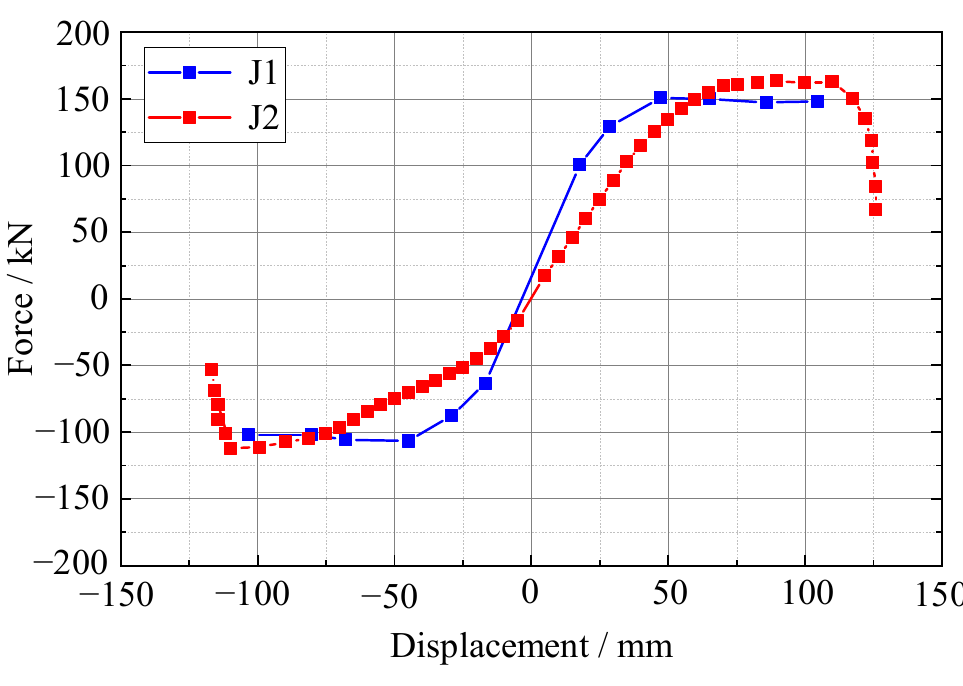
Figure 16. Comparison of test piece skeleton curves.